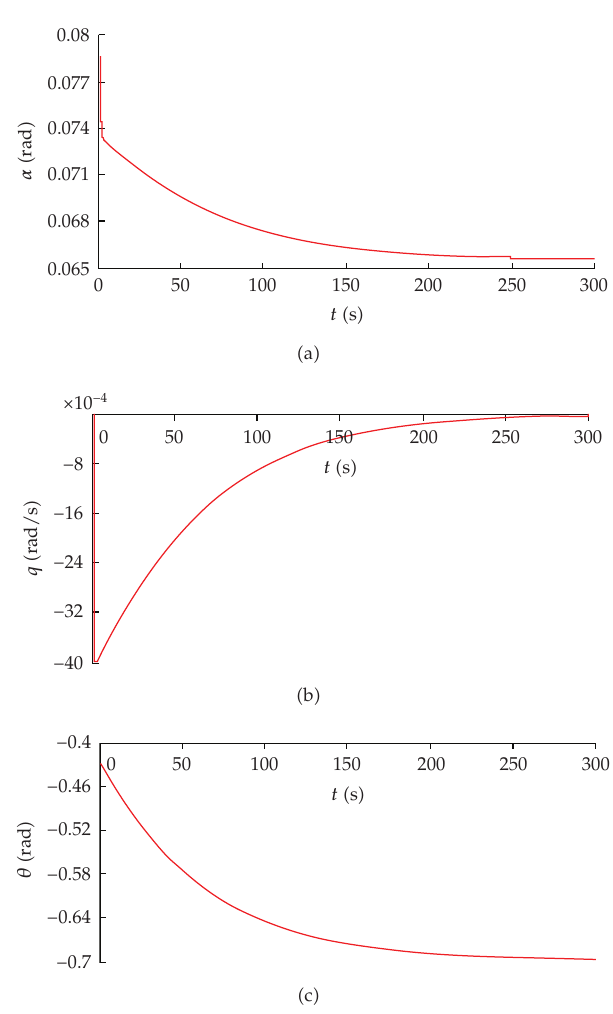
(cid:7) e (cid:7) 0 . 07866974 (cid:5) rad (cid:6) (cid:7) 4 . 509 ◦ ; q (cid:6) (cid:7) 0 (cid:5) rad / s (cid:6) ; 1 1 (cid:7) 0 (cid:5) rad / s (cid:6) ; θ (cid:6)(cid:6) (cid:7) − 0 . 698066 (cid:5) rad (cid:6) (cid:7) 1 1